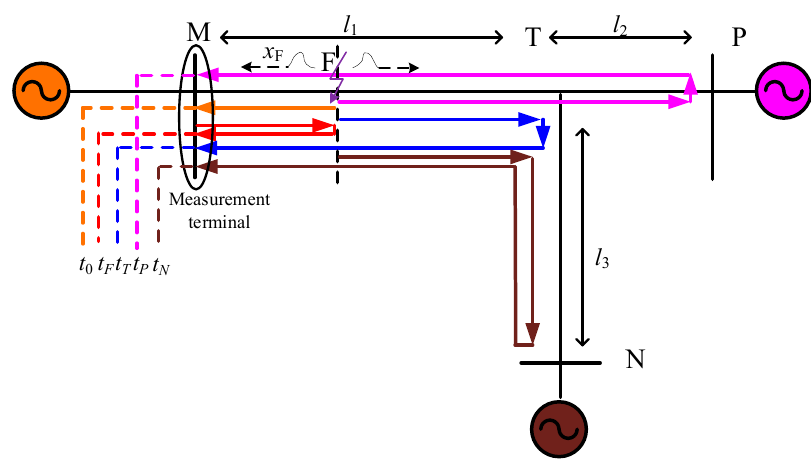
Figure 2. Travelling wave propagation path within x F < l 1 − x F < l 1 + l 2 − x F .